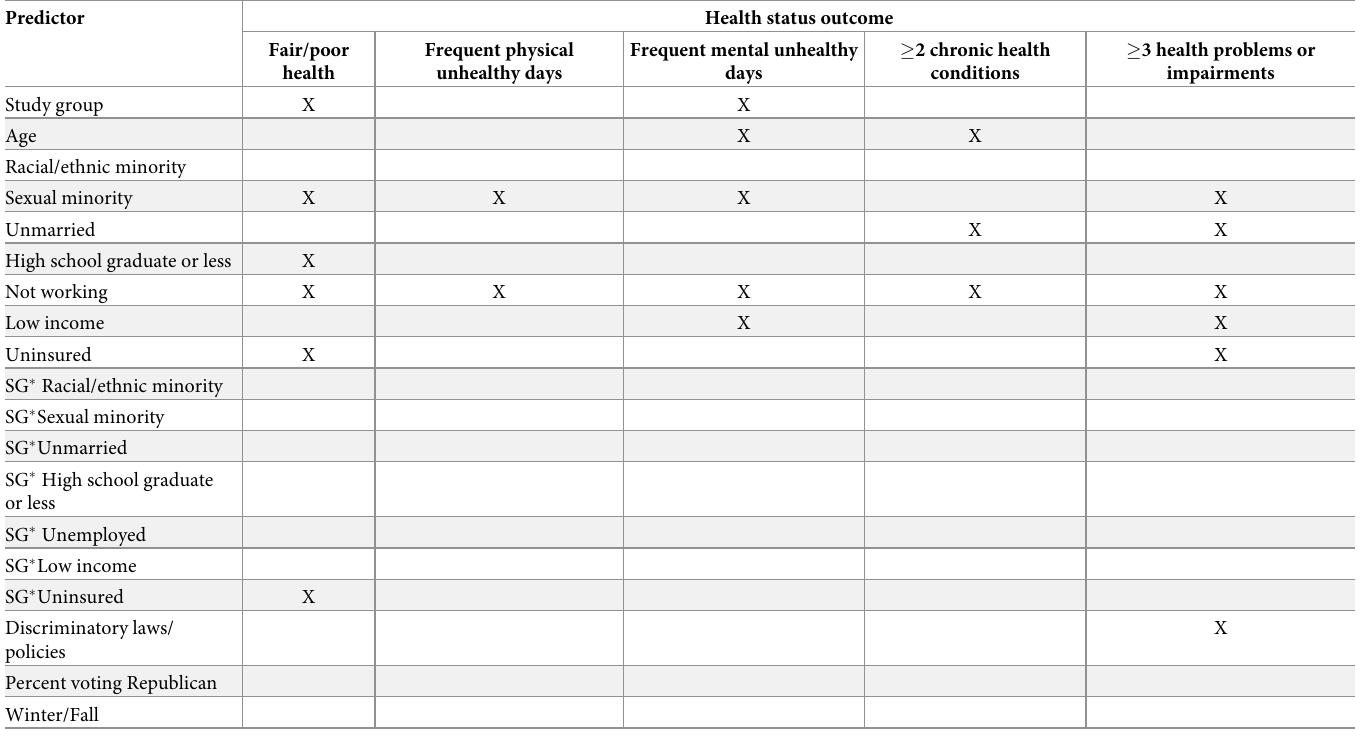
Table 5. Final multivariable model results: Summary of significant predictors for health status outcomes.